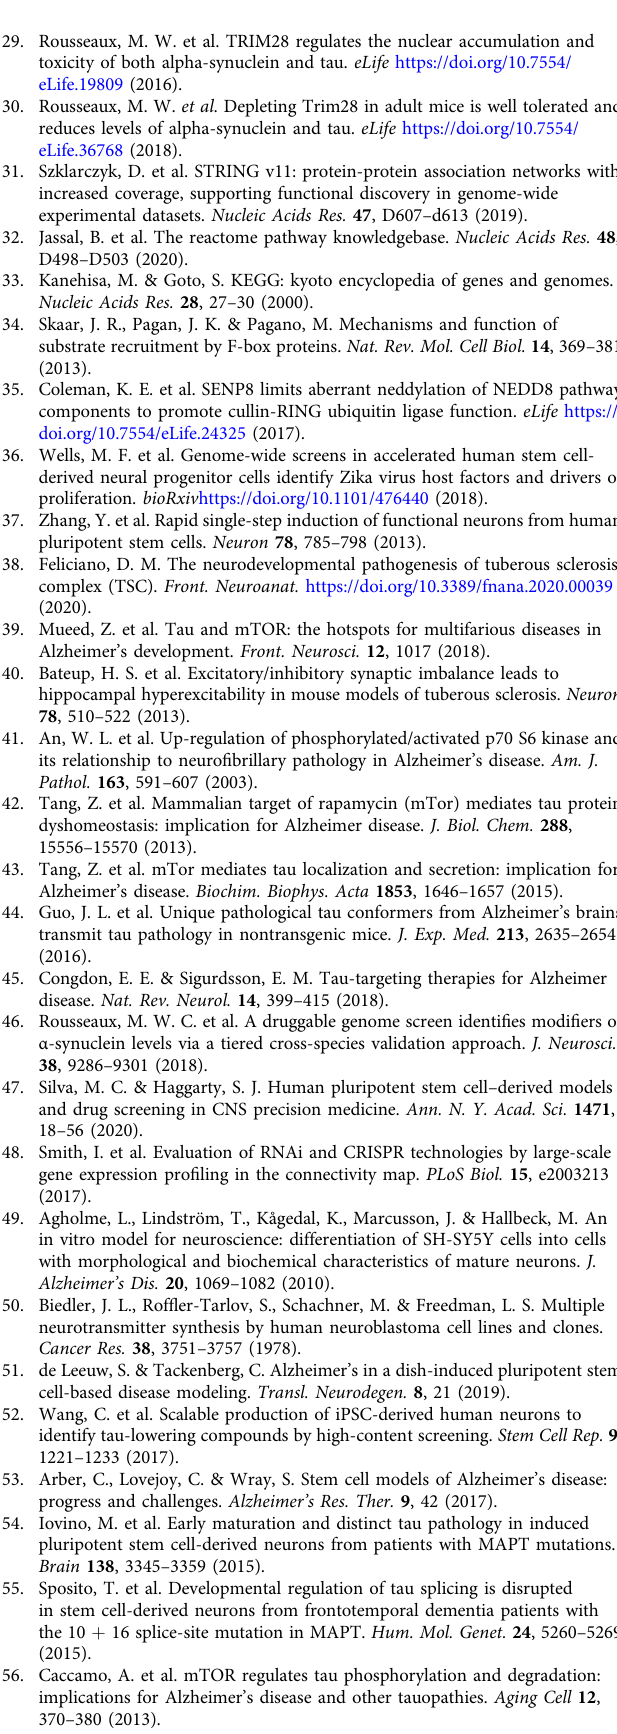
Fig. 1c is included in Supplementary Fig. 5a. The FACS gating strategy is shown in Supplementary Fig. 6. Any other relevant data are available from the authors on reasonable